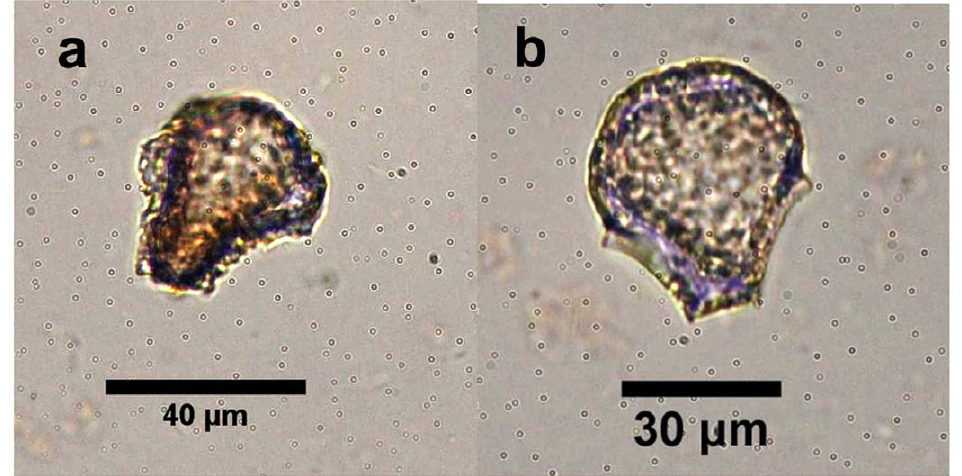
Figure 5. Possible rice bulliforms with dissolved surface from the Tanghu site.